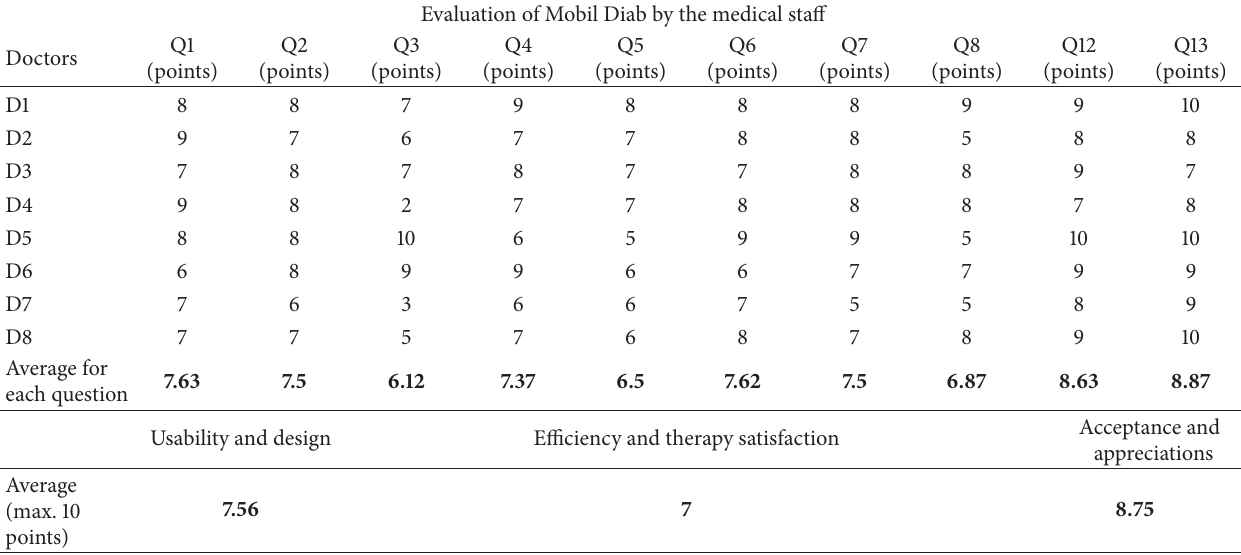
Table 2: Evaluation of usability, efficiency, and acceptance of Mobil Diab by the medical staff. Evaluation of Mobil Diab by the medical